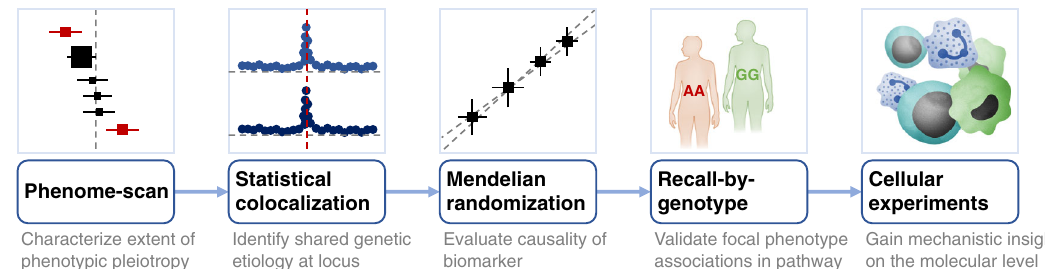
Fig. 1 Schematic overview of the study design to elucidate molecular underpinnings of cross-disease associations. Credits: The immune response, Big Picture